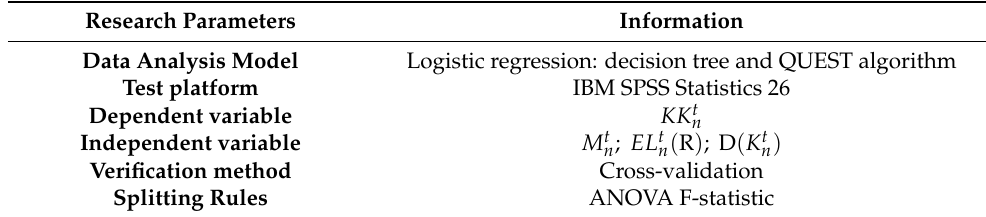
Table 9. Information on QUEST-related